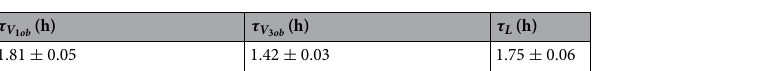
Table 3. Final results of the experimental growth rate exponents, from data shown in Table 2.